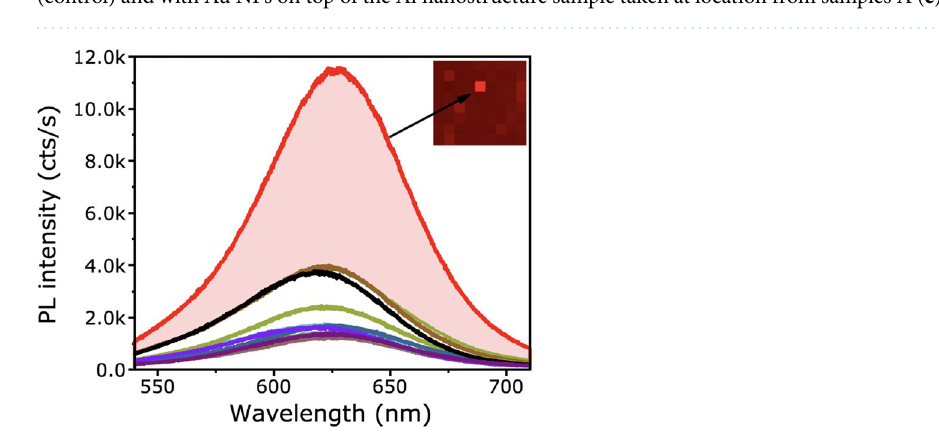
Figure 3. Representative set of PL emission obtained from different positions on the surface of the plasmonic nanostructure sample, with 5 μm steps at the selected marked area (B1). Inset: Mapping distribution of the same area, showing bright hotspots caused by plasmonic resonant enhancement from the Au